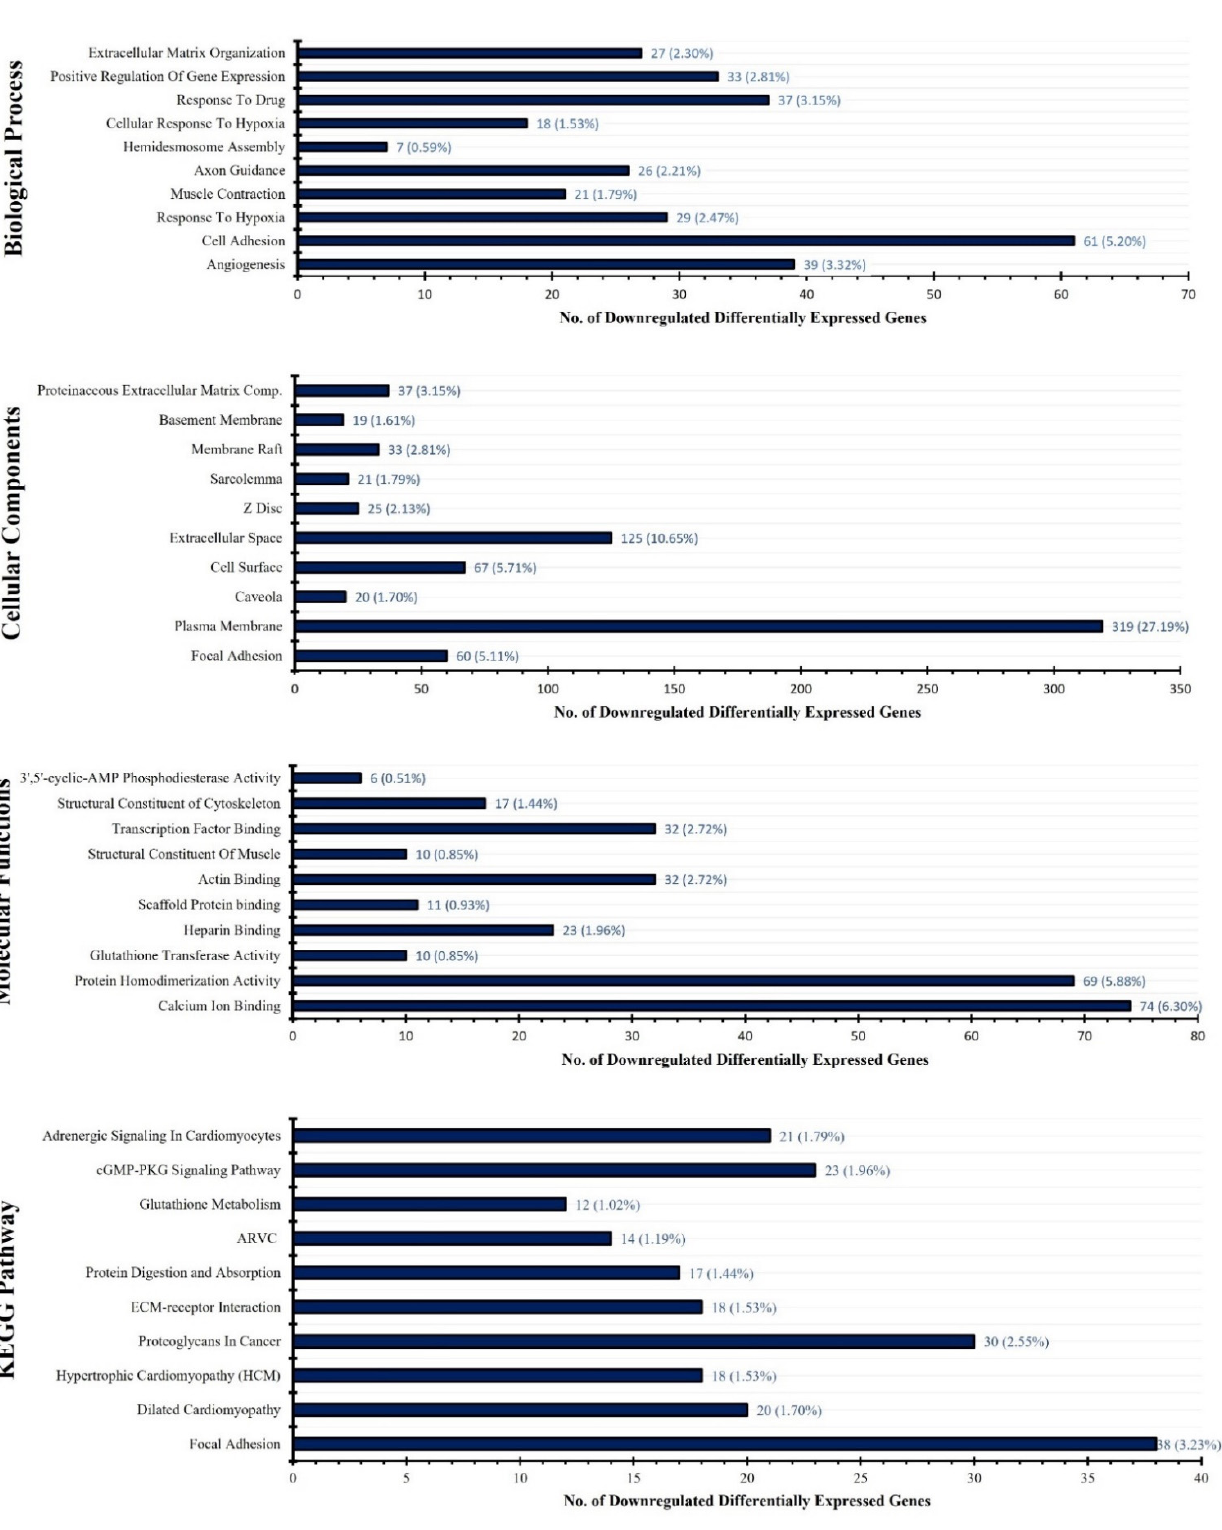
Figure 5. Gene ontology functional classification and pathway analysis of significant differentially expressed genes from various datafiles. Bar-graph of top most significant downregulated genes representing biological process, cellular component, molecular function, KEGG pathway analysis. KEGG (Kyoto Encyclopedia of Genes and Genomes ).